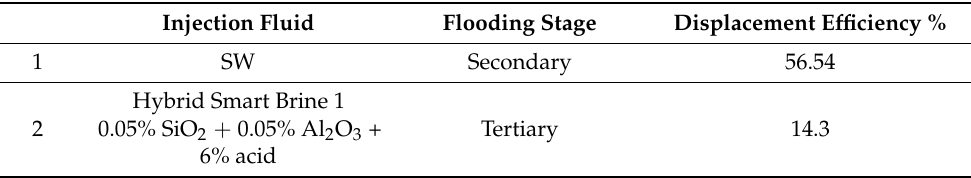
Table 19. Summary of